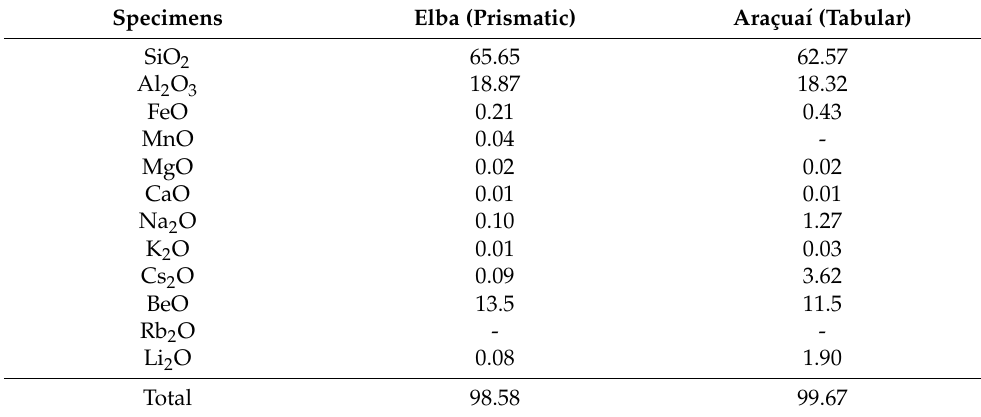
Table 4. Chemical composition of the two specimens of the beryl-group minerals used in Figure 5.